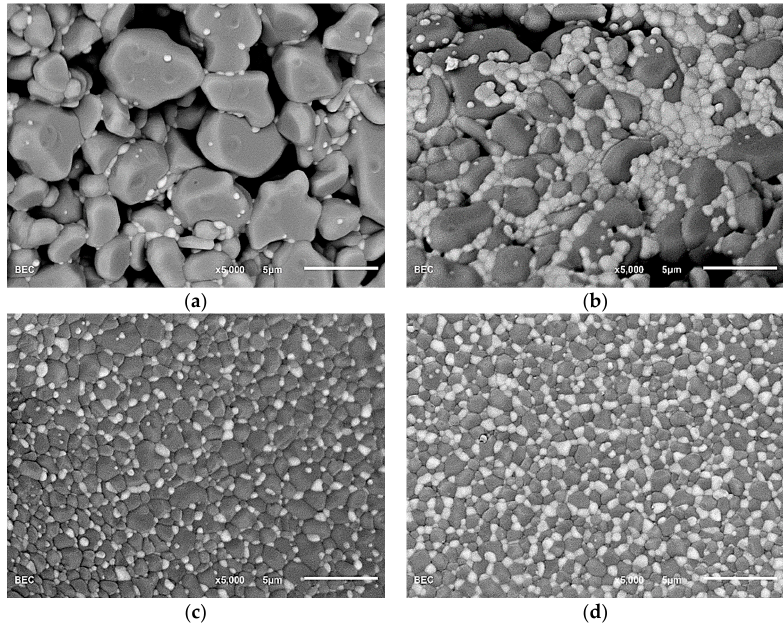
Figure 6. Typical BSE images of the reticulated porous ZTA specimens, zirconia amounts when using coarse alumina as a matrix: (a) at 10 wt. %, and (b) at 40 wt. %; zirconia amounts when using fine alumina as a matrix: (c) 10 wt. %, and (d) 40 wt. %.